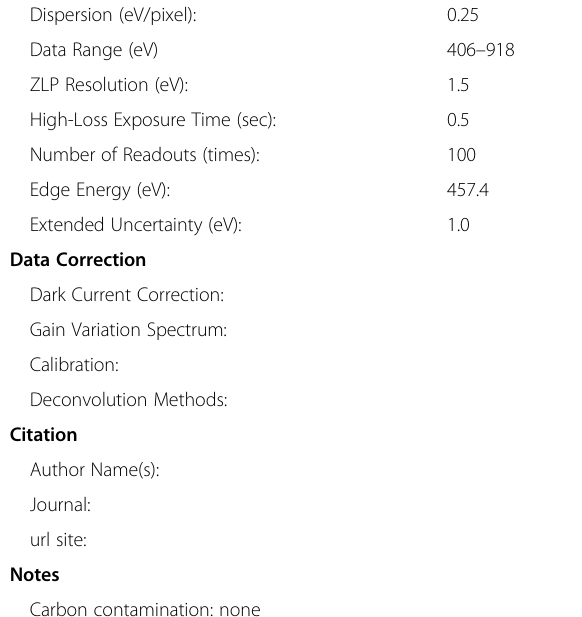
Table 1 Meta information of EEL SR